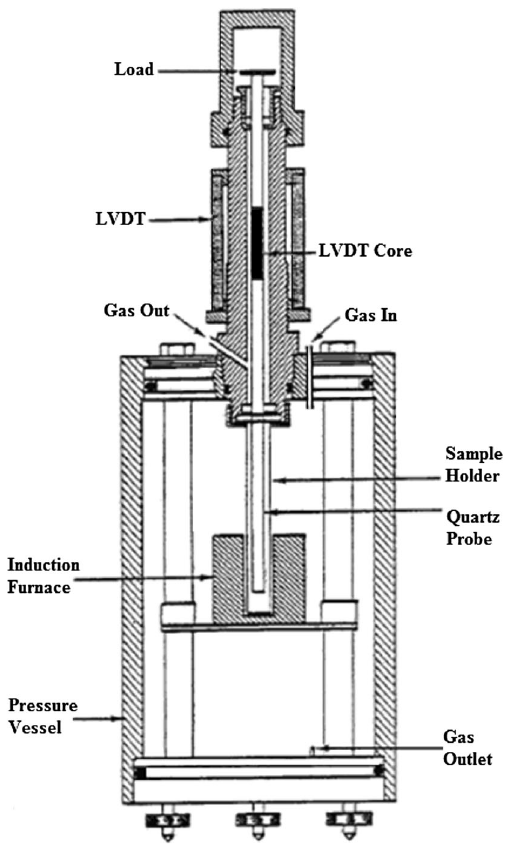
Fig. 1 High-pressure micro-dilatometer (HPMD)